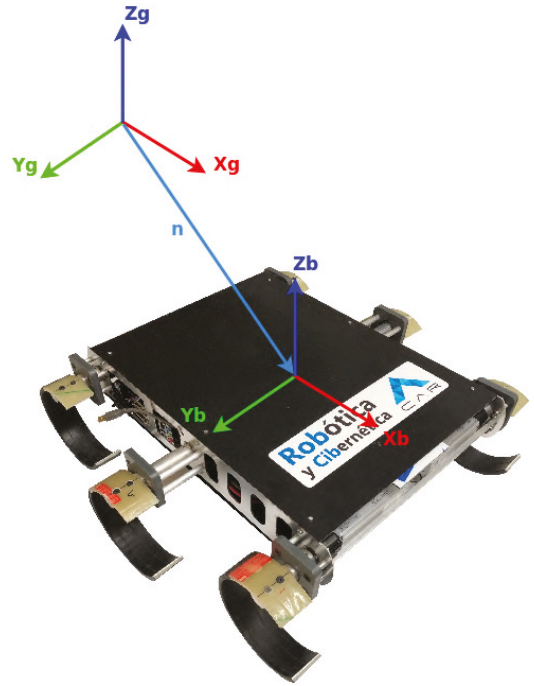
Figure 3. Global (G) and Body-fixed (B) Coordinate Frames for CLHeRo V2.5. Table 2. Physical properties of the robots. All measures in mm, except the total weight (kg).